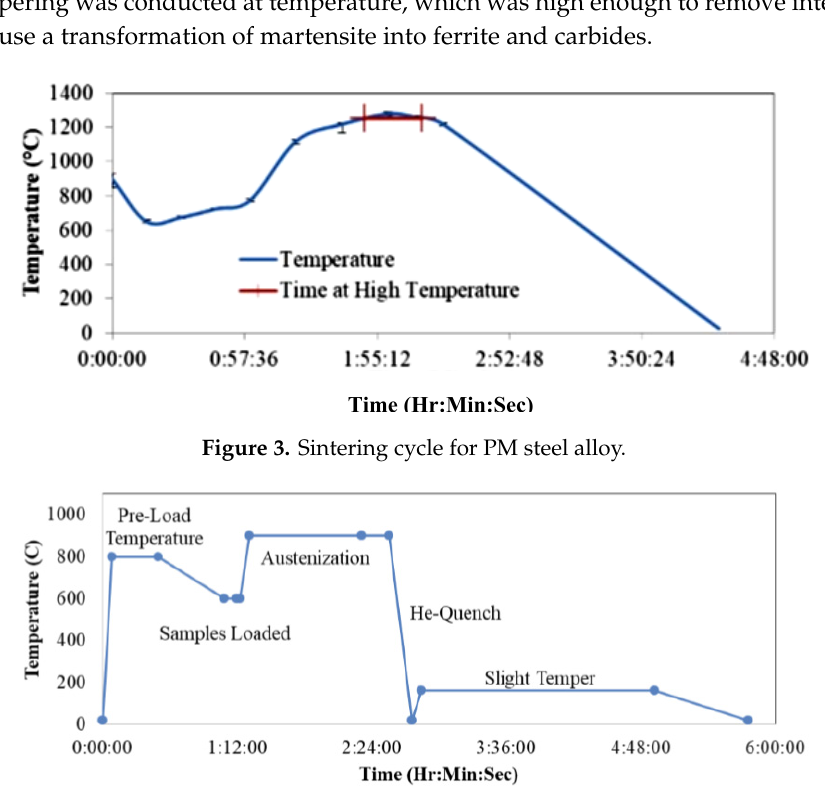
Figure 4. Heat treatment cycle for powder metallurgy (PM) steel alloy.